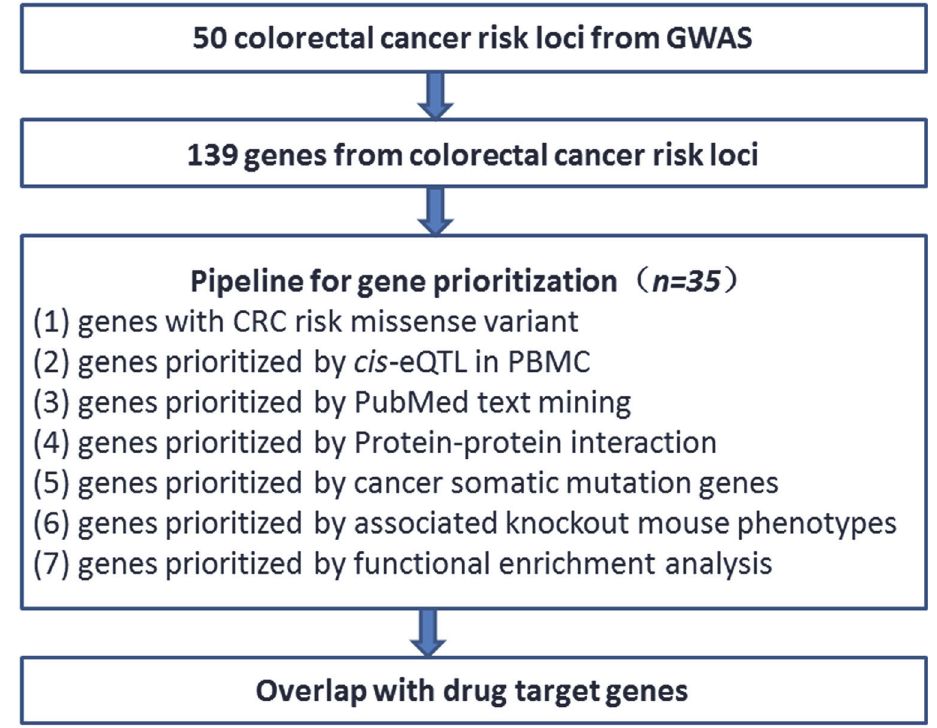
Fig 1. An overview of the study design. One hundred and forty-seven candidate genes were obtained from 50 CRC risk loci. A bioinformatics pipeline was developed for the prioritization of these candidate genes. Seven criteria were used to score the genes: (1) CRC risk missense variant; (2) cis -eQTL; (3) PubMed text mining; (4) PPI; (5) cancer somatic mutation; (6) knockout mouse phenotype; and (7) functional enrichment. Extent of overlap with target genes for approved CRC drugs was also